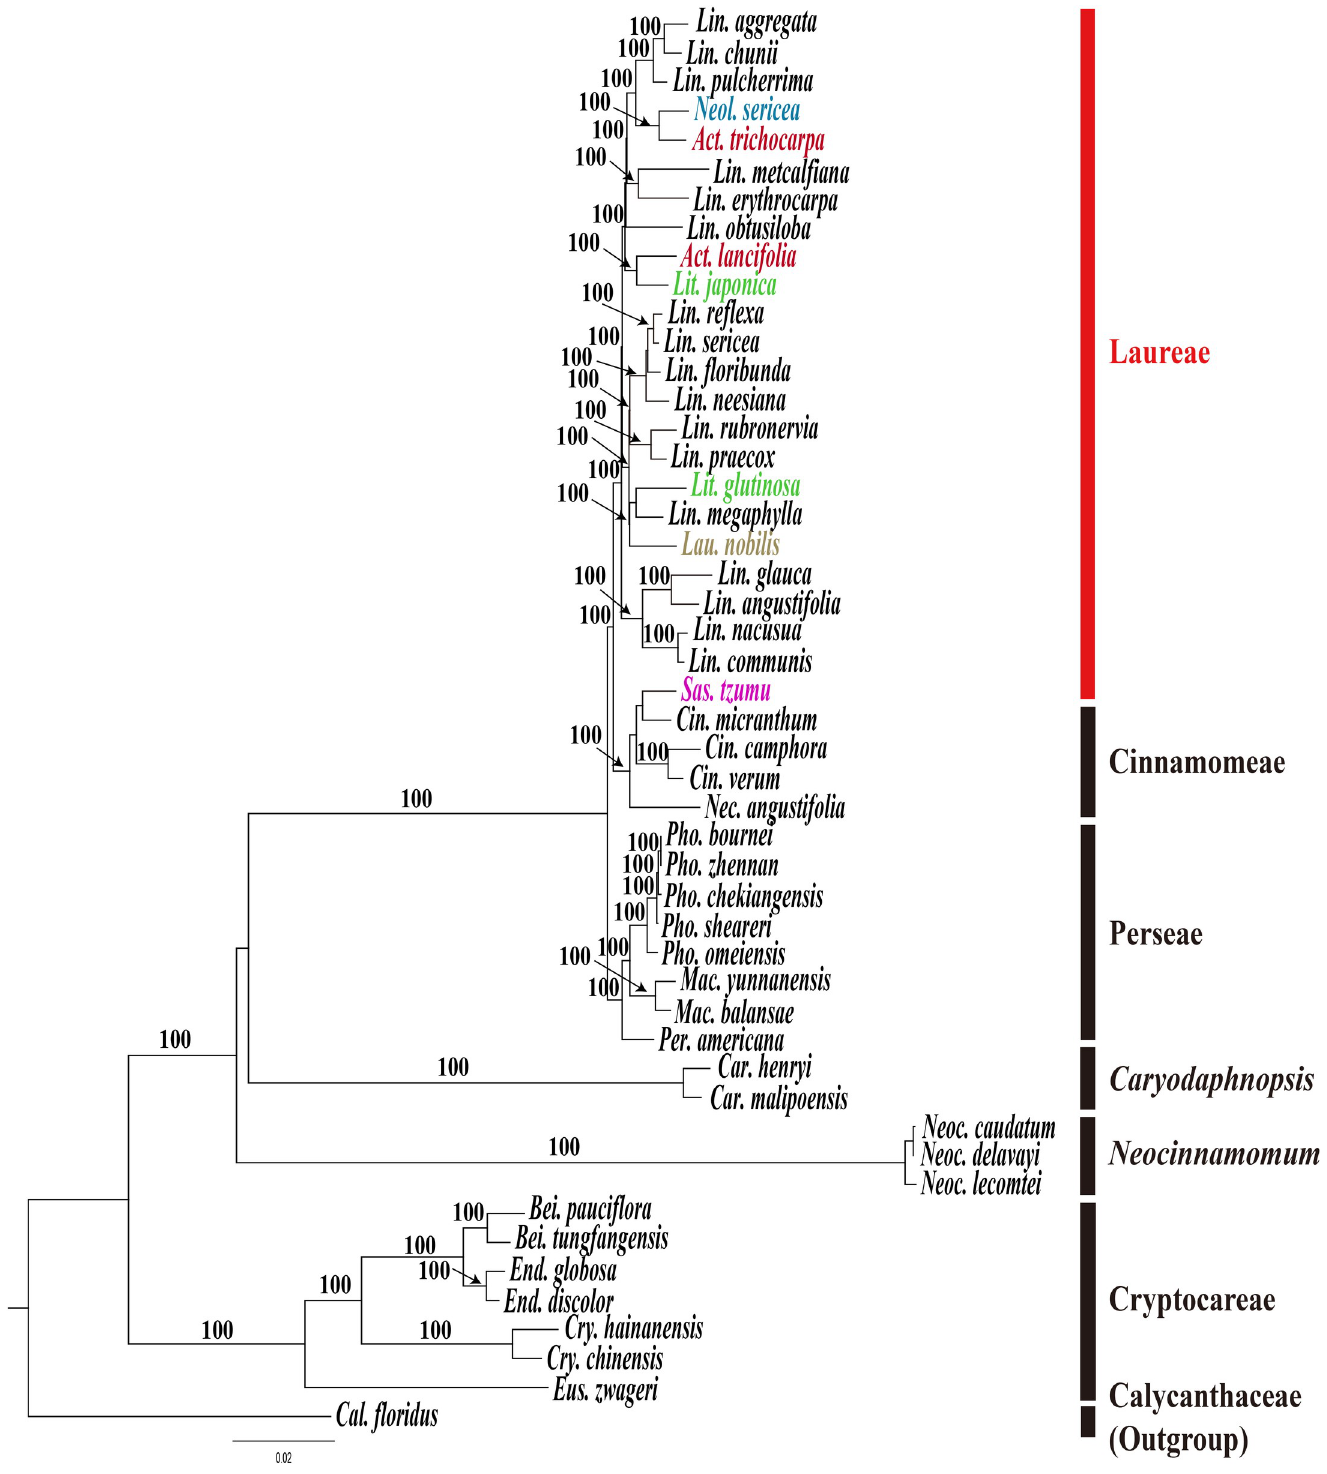
Fig 6. Maximum likelihood (ML) tree for 49 Lauraceae based on 77 protein-coding and four rRNA gene sequences of plastome. The aligned sequence was 73,193 bp in length. The ML tree was determined by RAxML with -ln L = 294926.225755. The number on each node indicates the ML bootstrap value above 95% supports. Abbreviations: Act . = Actinodaphne , Bei . = Beilschmidedia , Cal . = Calycanthus , Car . = Caryodaphnopsis , Cin . = Cinnamomum , Cry . = Cryptocarya , End . = Endiandra , Eus . = Eusideroxylon , Lau . = Laurus , Lin . = Lindera , Lit . = Litsea , Mac . = Machilus , Nec . = Nectandra , Neoc . = Neocinnamomum , Neol . = Neolitsea , Per . = Persea , Pho . = Phoebe and Sas . = Sassafras